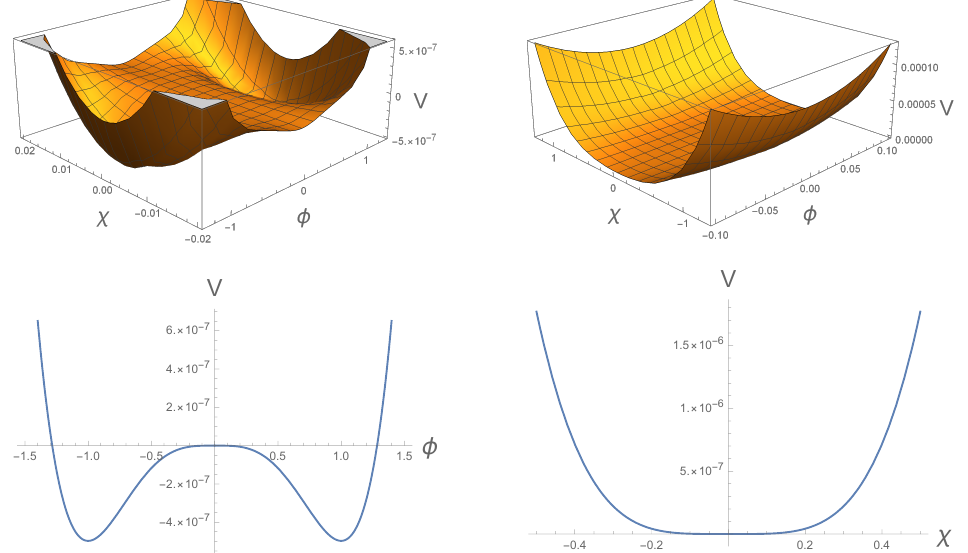
Figure 3: Plots of the effective potential for N = 1. There are two three-dimensional plots: one with narrow range of φ only has two minima along the χ three-dimensional plot when φ